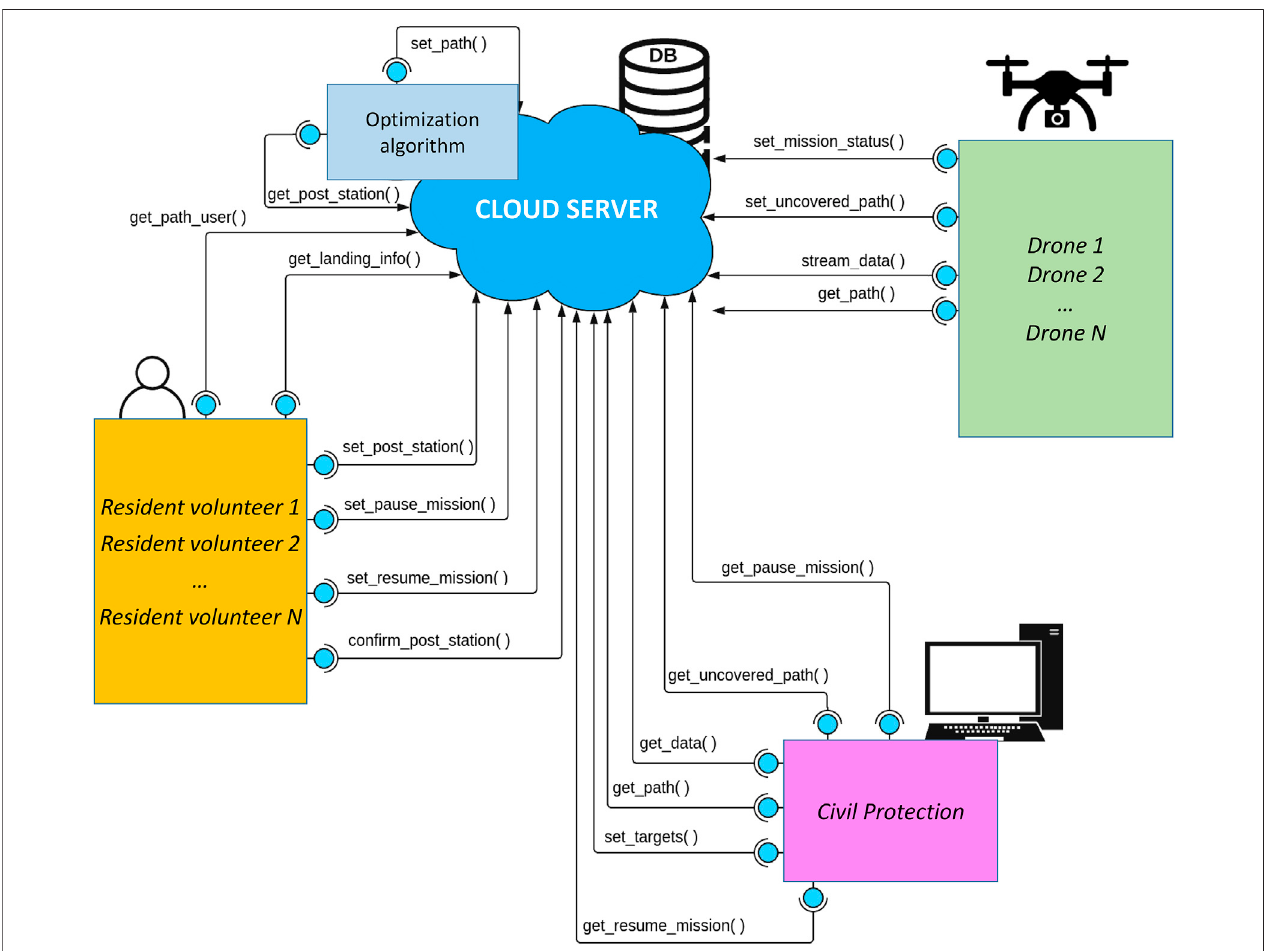
FIGURE 3 | Cloud-based architecture with actors (Civili protection, residents volunteers, drones) and web services implemented.